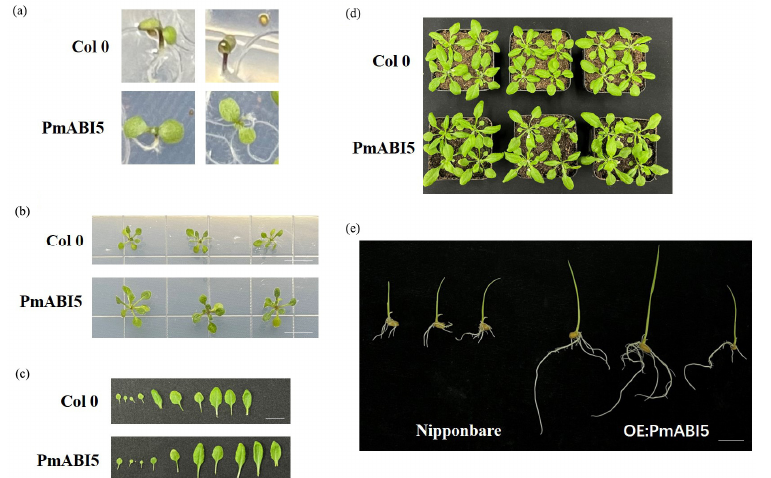
Figure 9. Identification of root traits of transgenic Arabidopsis PmABI5 -overexpressing lines. ( a ) OE: PmABI5 alleviates plant stress. ( b ) 15-day-old OE: PmABI5 and Col-0. Scale bars = 1 cm. ( c ) The leaf phenotype of germinated 6-week OE: PmABI5 . Scale bars = 2 cm. ( d ) The whole plant phenotype of germinated 6-week OE: PmABI5 . ( e ) Root phenotype of PmABI5 rice overexpression lines. Scale bars = 1